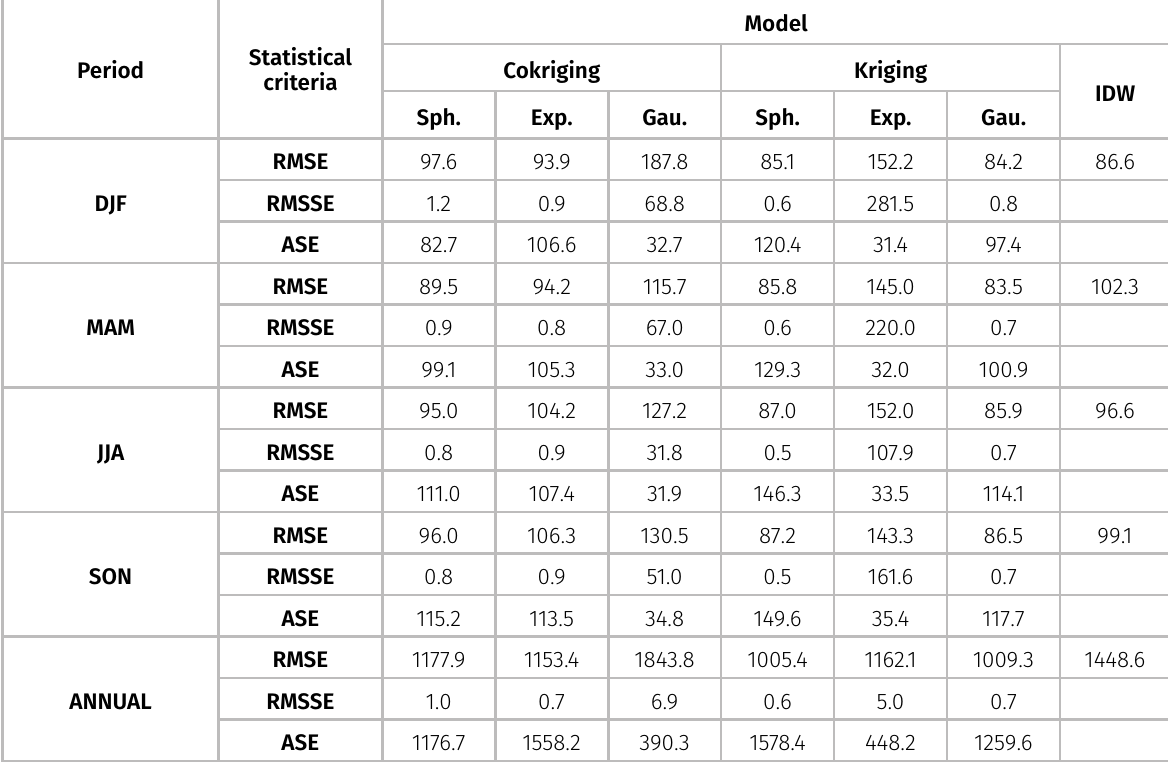
Table II. Cross-validation comparison for the CBC interpolation models.